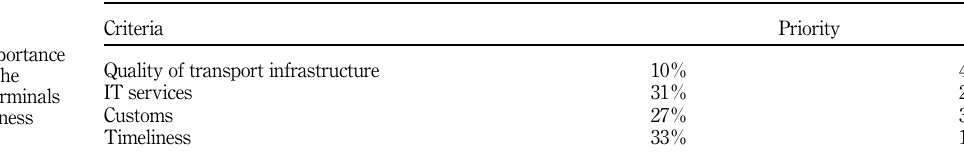
Table 5. Relative importance weights of the container terminals competitiveness